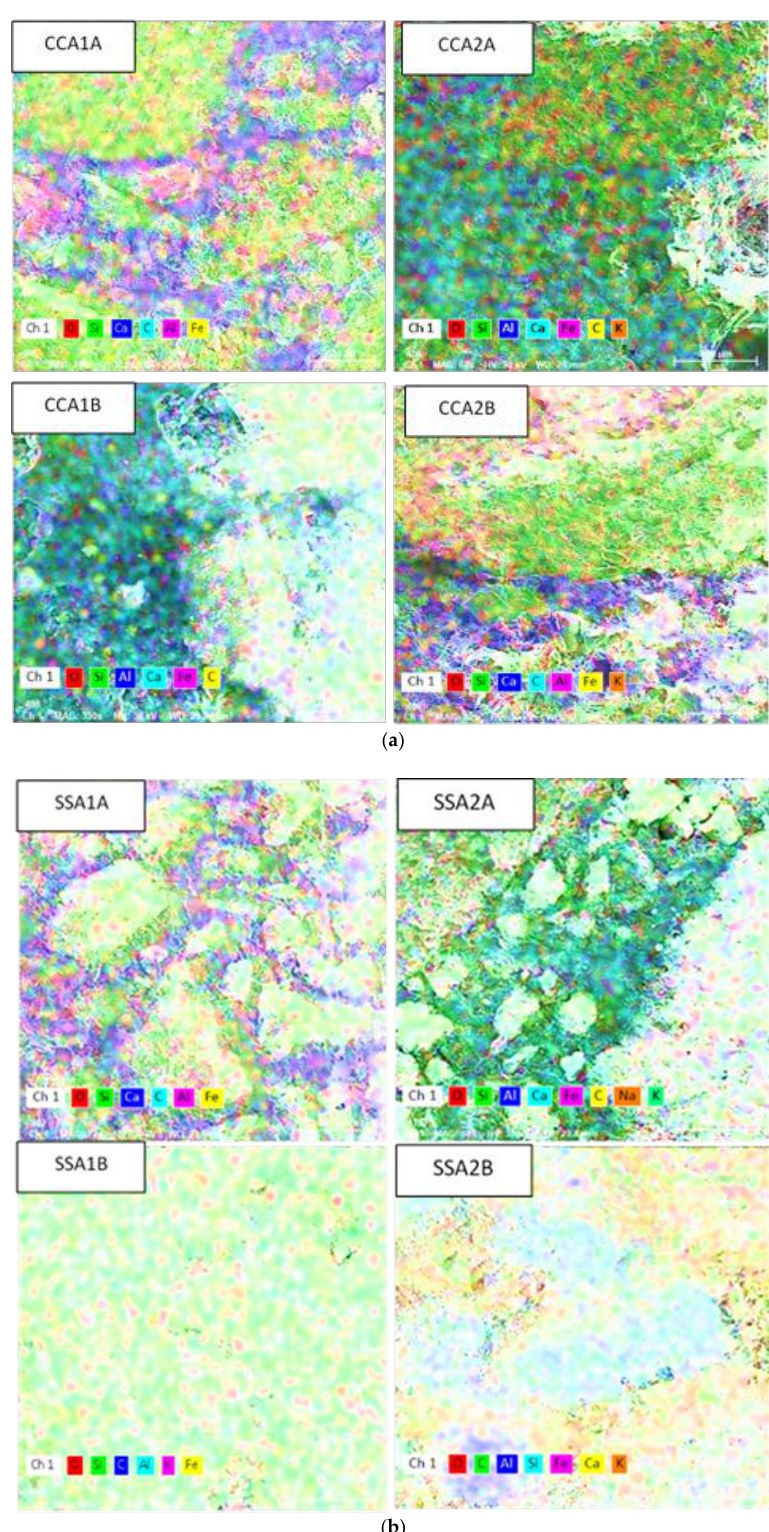
Figure 5. The distribution of the main identified elements in the studied concretes, at the magnification rate of 400 µm: ( a ) CCA concretes, ( b ) SSA concretes.